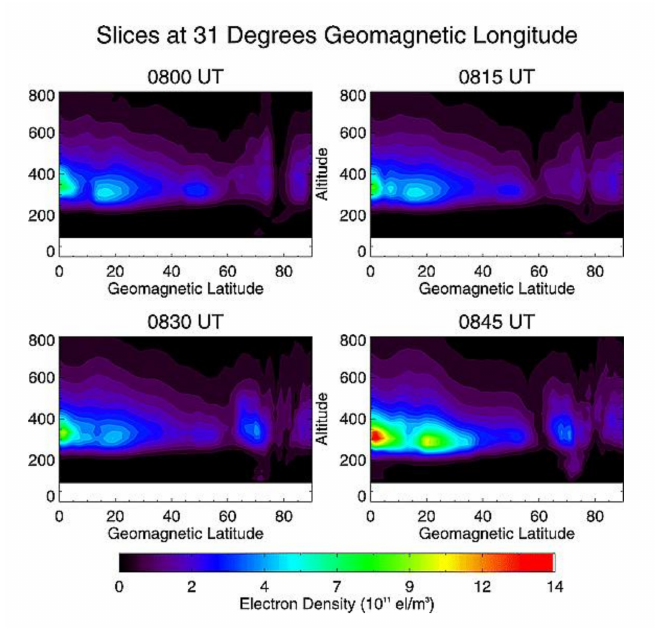
Figure 14. Tomographic images of an ionospheric trough from 0800 to 0900 UT along a geomagnetic longitude of 31 ◦ E (from